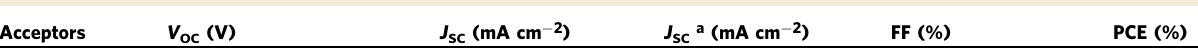
Supplementary Table 10. In terms of device stability, the Qx-